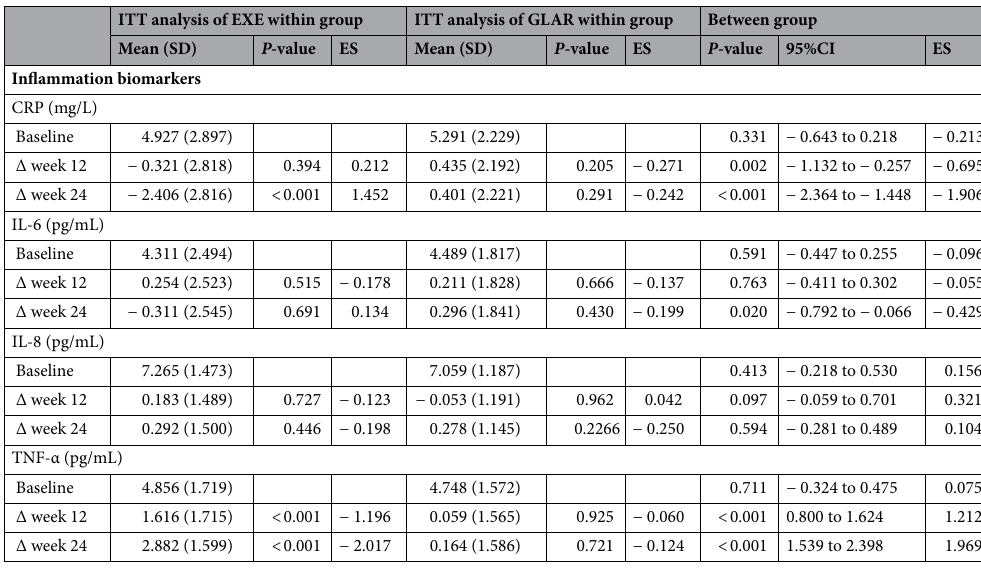
Table 2. Baseline value and estimate change in the anthropometric composition parameters, biochemical variables and inflammation biomarkers in two groups at 12 and 24 weeks. Data are presented as mean (SD). Between-group and Within-group comparisons were analyzed by Linear mixed-effects model analysis. BMI, body mass index; WHR, waist-hip ratio; VFA, visceral fat area; FBG, fasting blood glucose; HbA1C, glycosylated hemoglobin; TCH, total cholesterol; TG, triglycerides; LDL-c, low-density lipoprotein cholesterol, HDL-c, high-density lipoprotein cholesterol; CRP, C-reactive protein; IL-6, interleukin-6; IL-8, interleukin-8; TNF-α, tumor necrosis